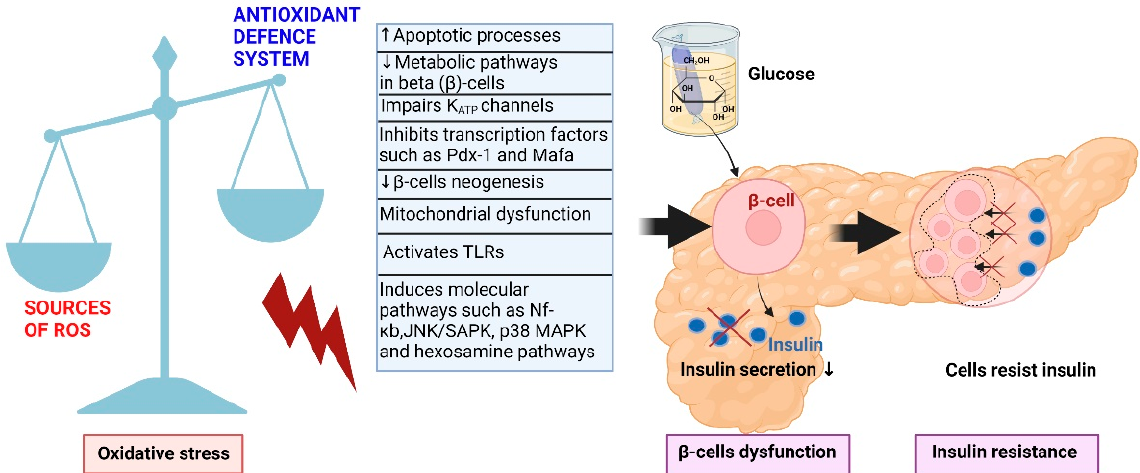
Figure 7. Graphical presentation of possible molecular mechanisms leading to DM. DM, diabetes mellitus; Pdx-1, insulin promoter factor 1; MafA, a transcription factor; TLRs, toll-like receptors; Nf- κ b, nuclear factor kappa b; p38 MAPK, p38 mitogen-activated protein kinases; JNK/SAPK, stress- activated protein kinase/c-Jun NH(2)-terminal kinase. The figure is drawn with Biorender, based on data from [75] under the open access Creative Commons license.